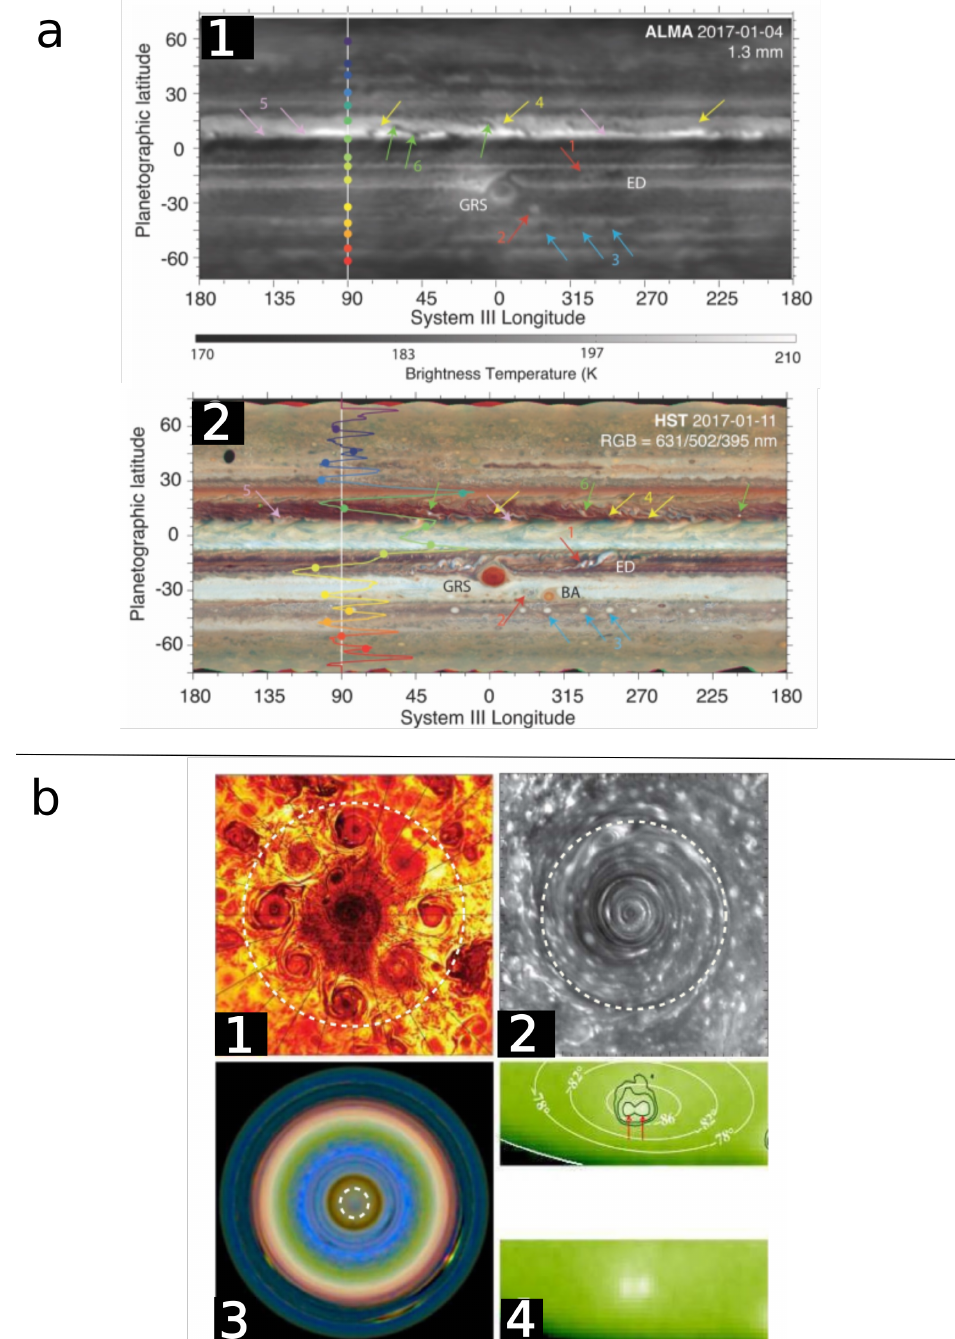
Figure 13. Banded Structure of Jupiter and Polar Cyclones. ( a1 ) 1.3 mm Radio Map of Jupiter. ( a2 ) RBG HST Image of Jupiter showing zonal wind direction as a function of latitude and various features. a. Reproduced from de Pater et al. [198] ( b1 ) Jupiter. ( b2 ) Saturn, close − up of North Polar Cyclone. ( b3 ) Uranus. ( b4 ) Neptune. Figure reproduced from Brueshaber et al. [199] and references